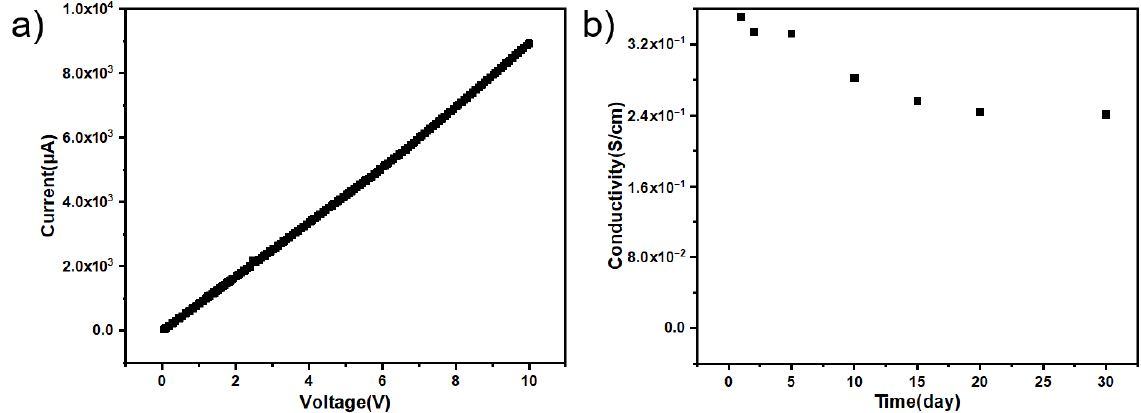
Figure 13. In-situ polymerization deposition of PPy/CNCs on paper substrate ( a ) I−V curve of a conductive paper (30 mm long, 5 mm wide and 100 μm thick) . ( b ) Conductivity stability of the conductive paper.